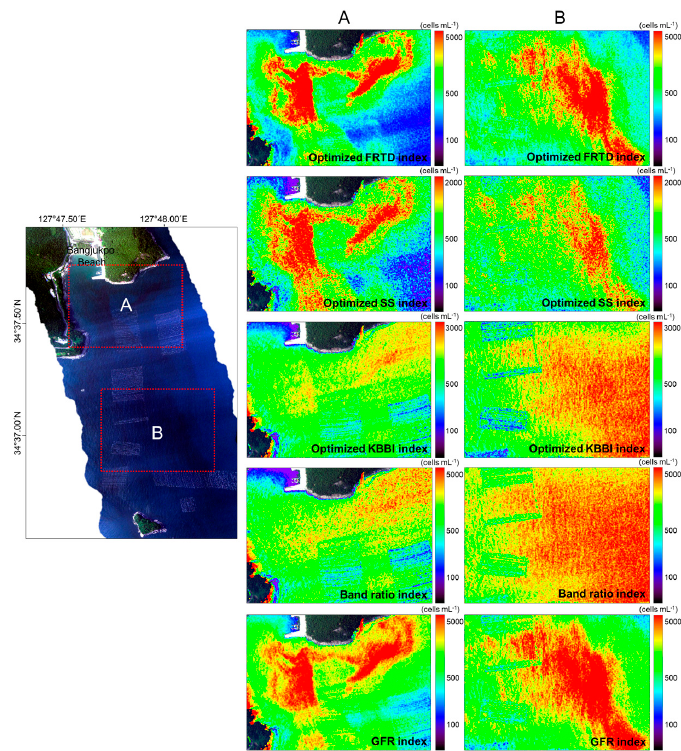
Figure 8. HSI true-color composite image (R, 639.52 nm; G, 550.58 nm; B, 469.92 nm) and M. polykrikoides cell abundance maps near Bangjukpo Beach in Yeosu on 8 August 2018. Sections ( A ) and ( B ) in the HSI image are enlarged on the right panels. M. polykrikoides cell abundance maps were generated using optimized red tide indexes, the band ratio index, and the GFR index.